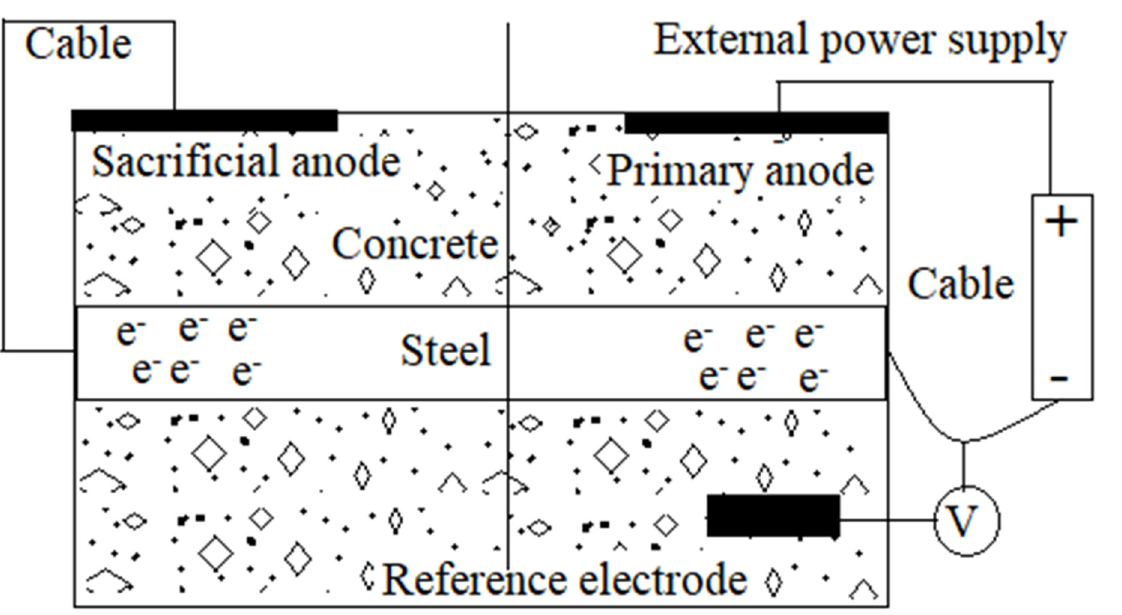
Figure 5. Cathodic protection process by the sacrificial anode and impressed current methods [87].